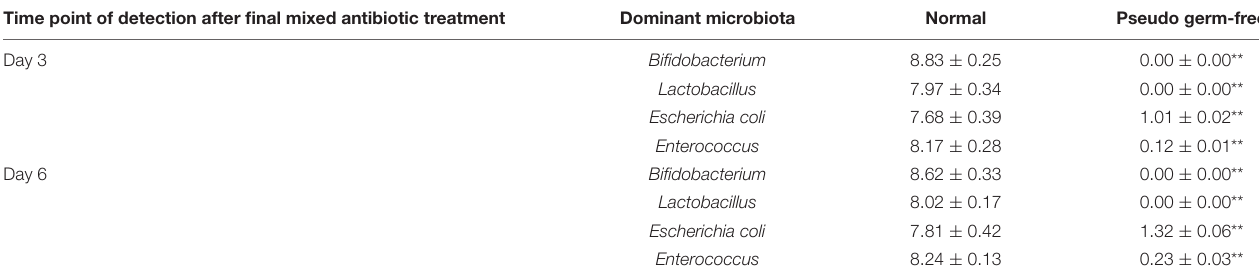
+ Data are expressed as the mean ± standard deviations of three replicates. Means of pseudo germ-free group with **are significantly different from the control group (p < 0.01). Normal mice refer to SPF C57BL/6J mice that did not receive the mixed antibiotic treatment.